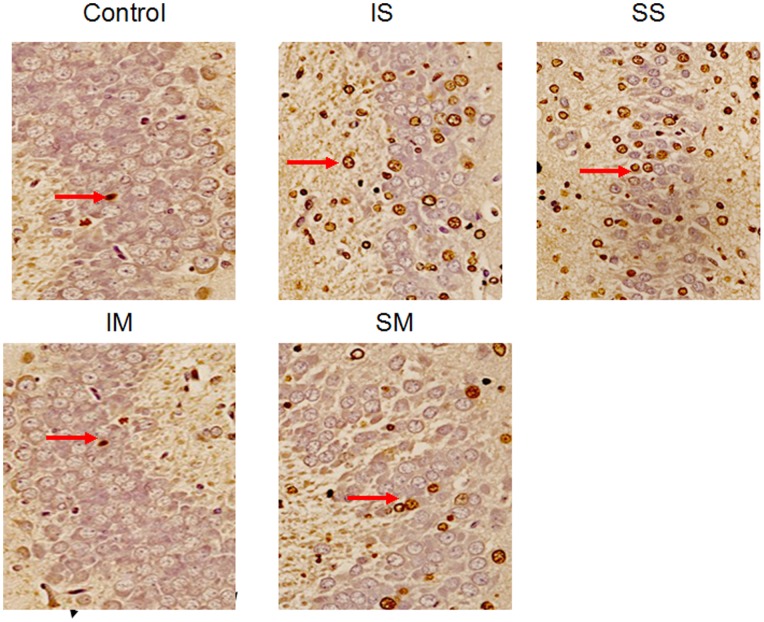
Images of the CA3 region in the hippocampus (5 µm) of five groups, the expression of the terminal deoxynucleotidyl transferase-mediated DNA nick-end labeling (TUNEL) apoptosis marker.Less cell death in the control and mechanically ventilated groups compared with the spontaneously breathing groups. Positively stained cells are chocolate brown, and arrows mark representative TUNEL-positive cells in each group. IS, isoflurane spontaneously breathing group; SS, sevoflurane spontaneously breathing group; IM, isoflurane mechanically ventilated group; SM, sevoflurane mechanically ventilated group.